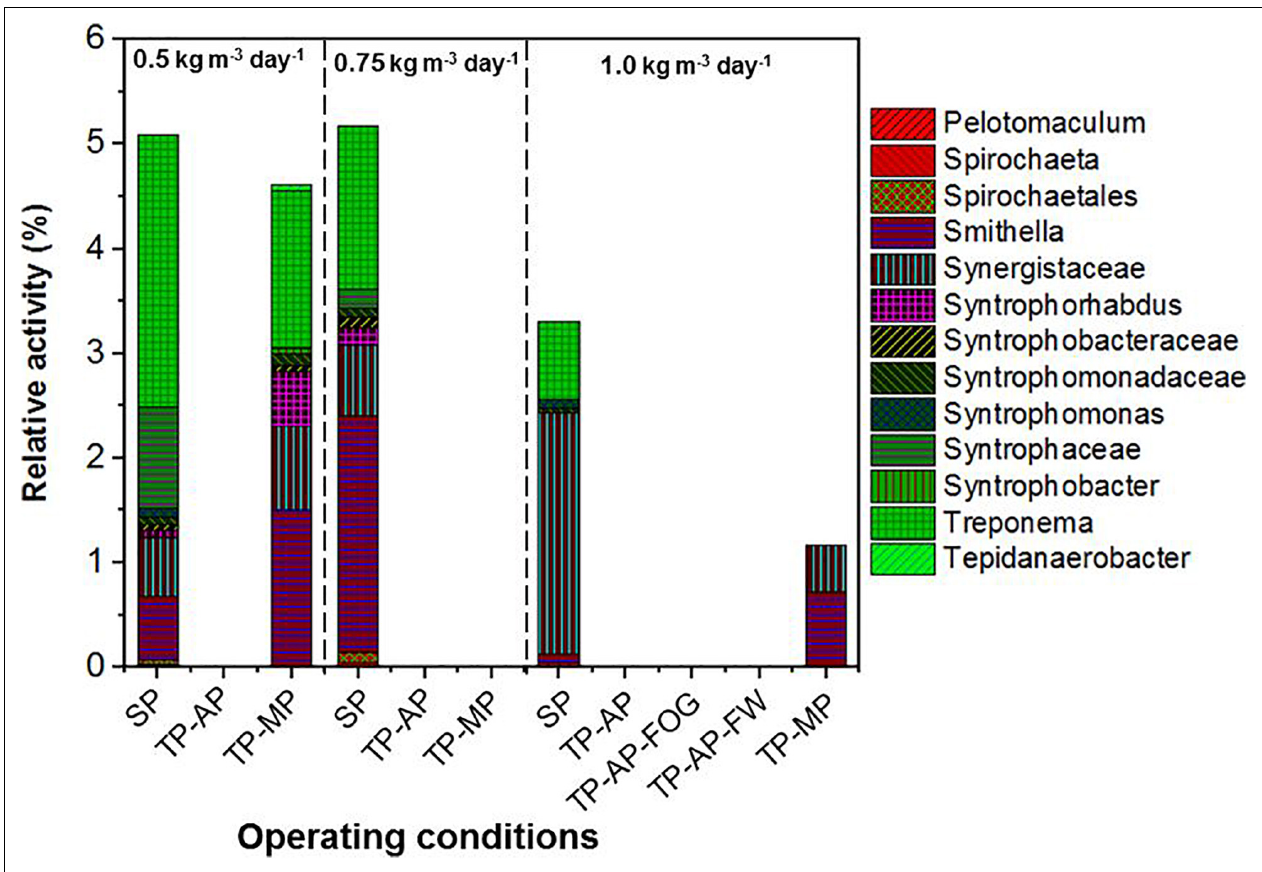
FIGURE 4 | Relative activity of syntrophic fatty acid oxidizers based on 16S rRNA sequencing identified at the genus level for different fat loadings and operating conditions. All data are expressed as a percentage of total 16S rRNA sequences (bacteria) per sample point.